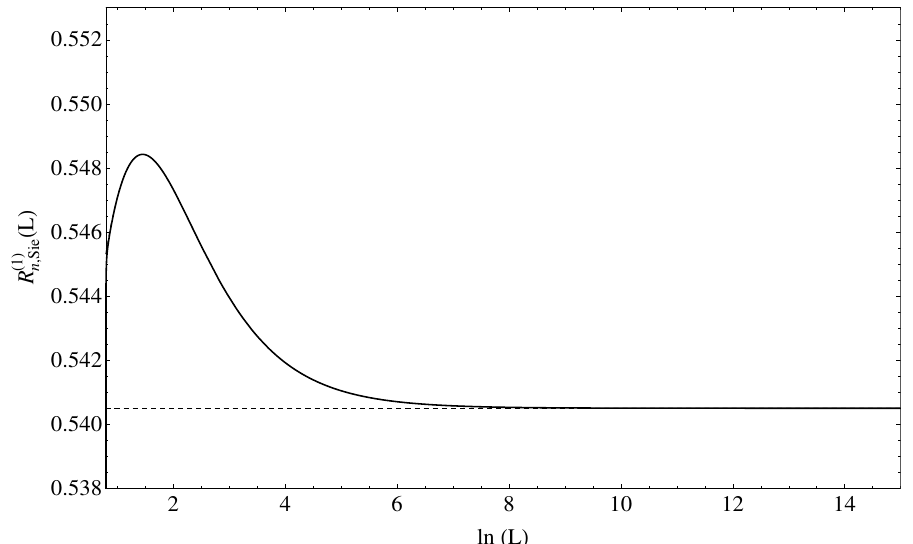
Figure 7 . Plot of the functions R (1) ( L ) for the tachyon vev as a function of the level in Siegel n; Sie gauge. The dashed line represents the asymptotic value 0 : 5405 obtained in reference [50]. The curves for n = 3 ; 4 ; 5 ; 6 ; 7 appear superimposed in the